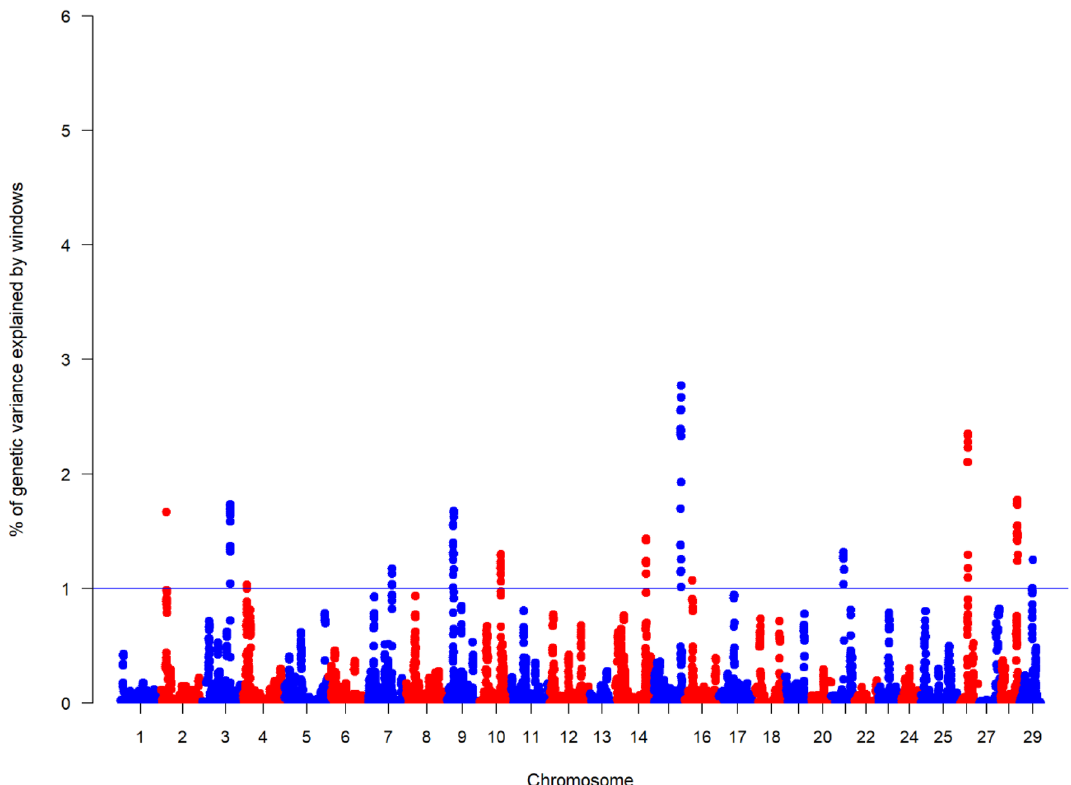
Figure 3. Weighted single-step GWAS (wssGWAS) results for Log lice density (LogLD) in rainbow trout. Manhattan plot represents the genetic variance explained by windows of 20 SNP and the blue horizontal line indicates 1% significance threshold.